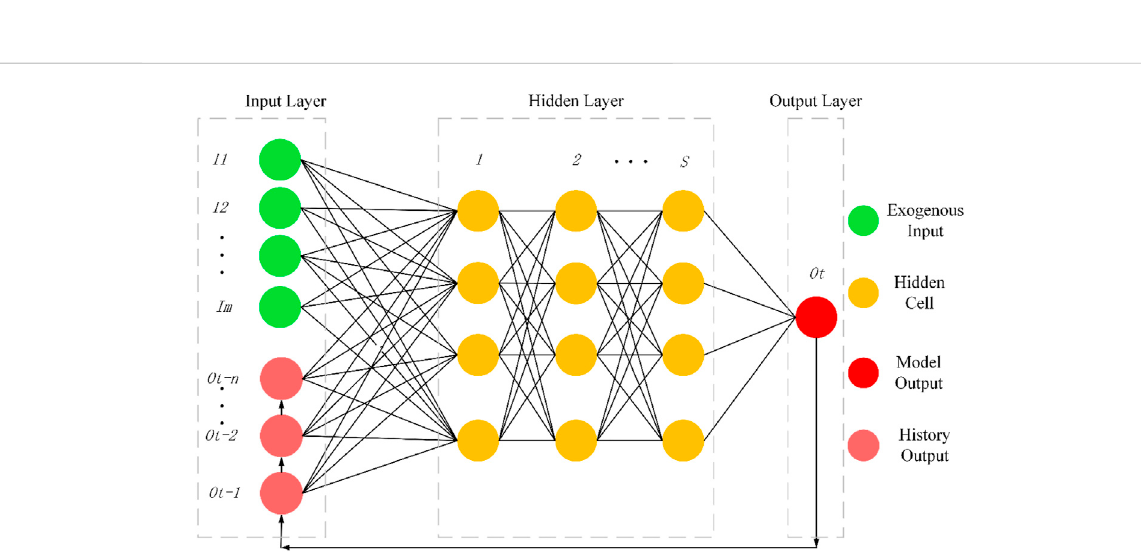
Frontiers in Earth